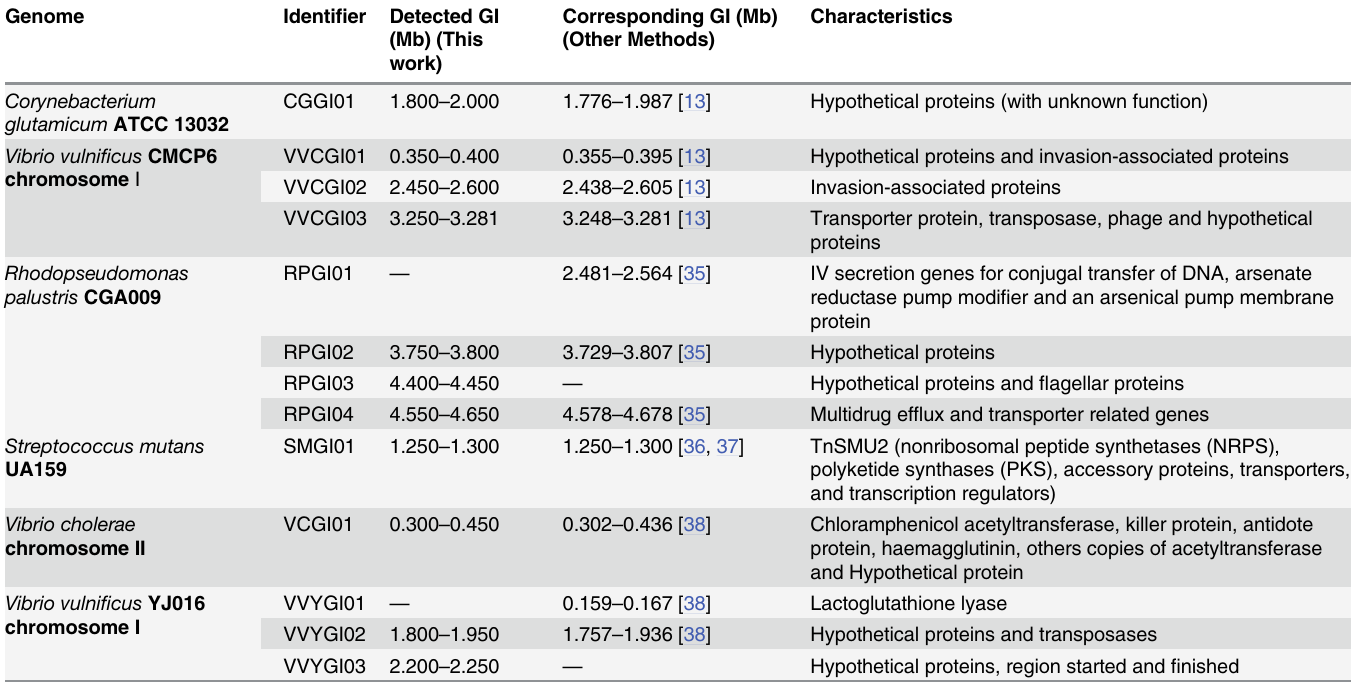
Table 2. Genomic islands detected by mean shift and its comparison with other methods previously used for each species. Genome Identi fi er Detected GI Corresponding GI (Mb) (Mb) (This (Other Methods) work)